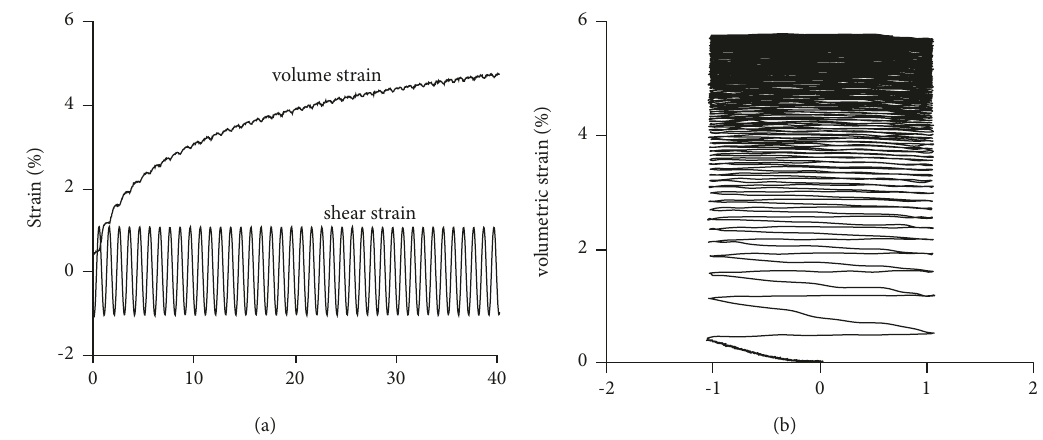
Figure 3: Typical curves of shear and volumetric strains for loess under cyclic direct simple shearing. (a) Number of cycles. (b) Shear